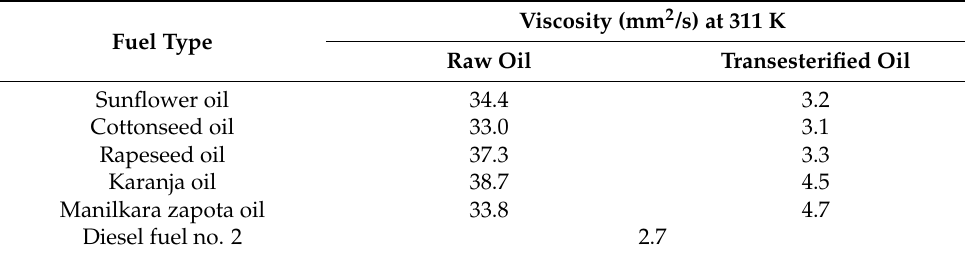
Table 1. The effect of transesterification on vegetable oils viscosities [26,27]. Fuel